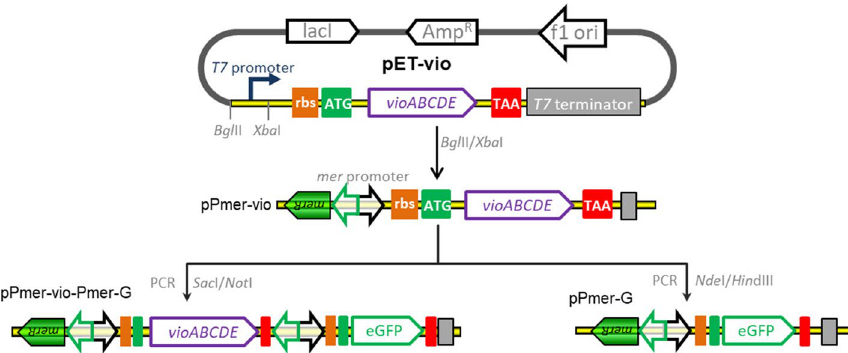
Figure 1. Assembly of artificial mer operons for sensing of bioavailable Hg(II). The violacein biosynthesis module and fluorescent reporter module were placed under the control of the mer promoter separately or in combination using genetic